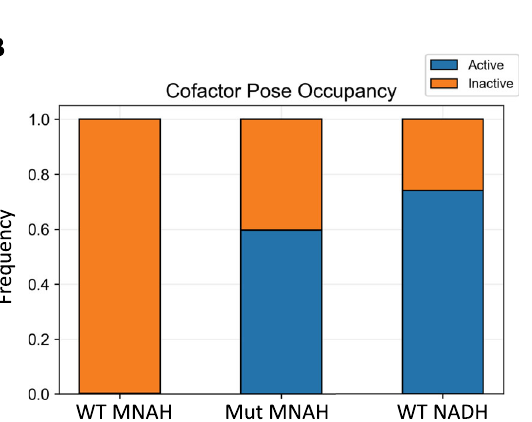
Fig.6|Measurementofhydridetransferef fi ciencyofwildtypeandengineered Lp Nox. A Electrons are shuttled from the nicotinamide cofactor (green) to FAD (yellow) through movement between the nicotinamide ring C4 and FAD N5. A catalytically competent enzyme must be able to support this contact, otherwise catalysiscannotoccur.Athresholdof4.5Åisboundedtocategorizebindingposes below as being active and poses with distances above as being inactive since the